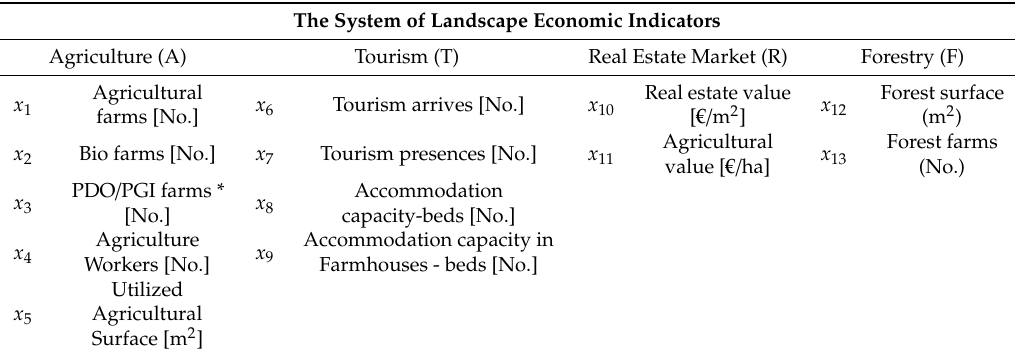
Table 2. The system of landscape economic indicators (Elaboration from Assumma et al., 2016). The System of Landscape Economic